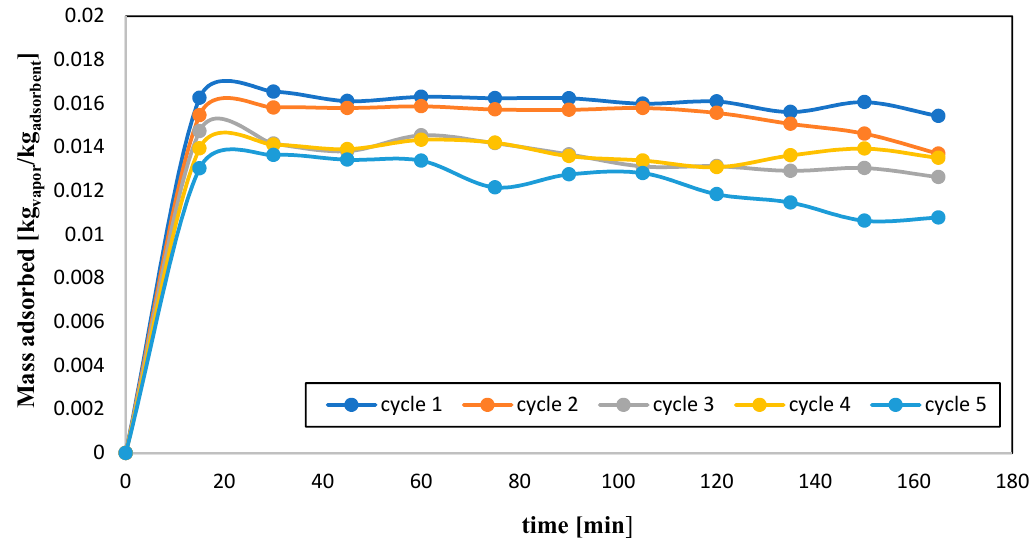
Figure 3. Phase mass adsorbed.